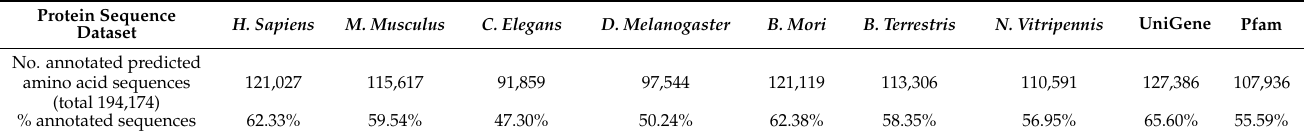
Table 1. Number of annotated amino acid